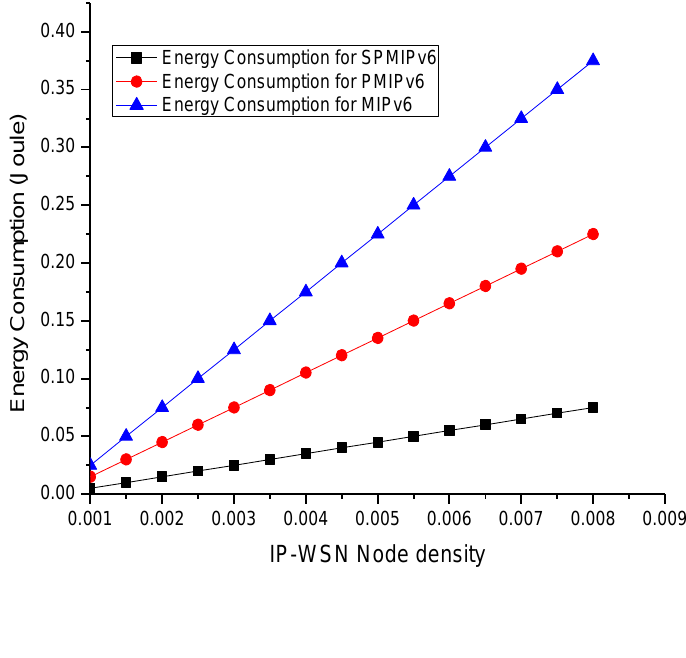
Figure 14. Node Density vs. Energy